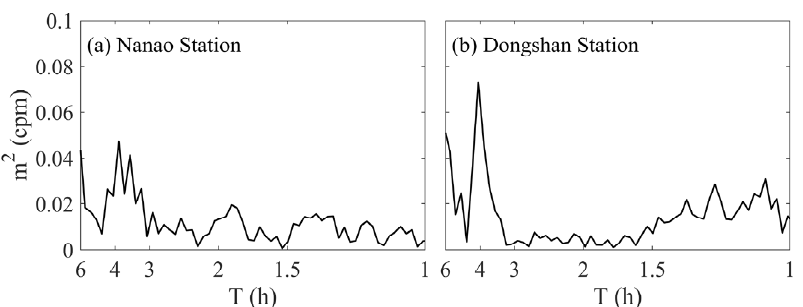
Figure 2. Power spectra of observed 10-min sea levels with tidal components removed at ( a ) Nanao and ( b ) Dongshan stations after the passage of Typhoon Mangkhut in September 2018.